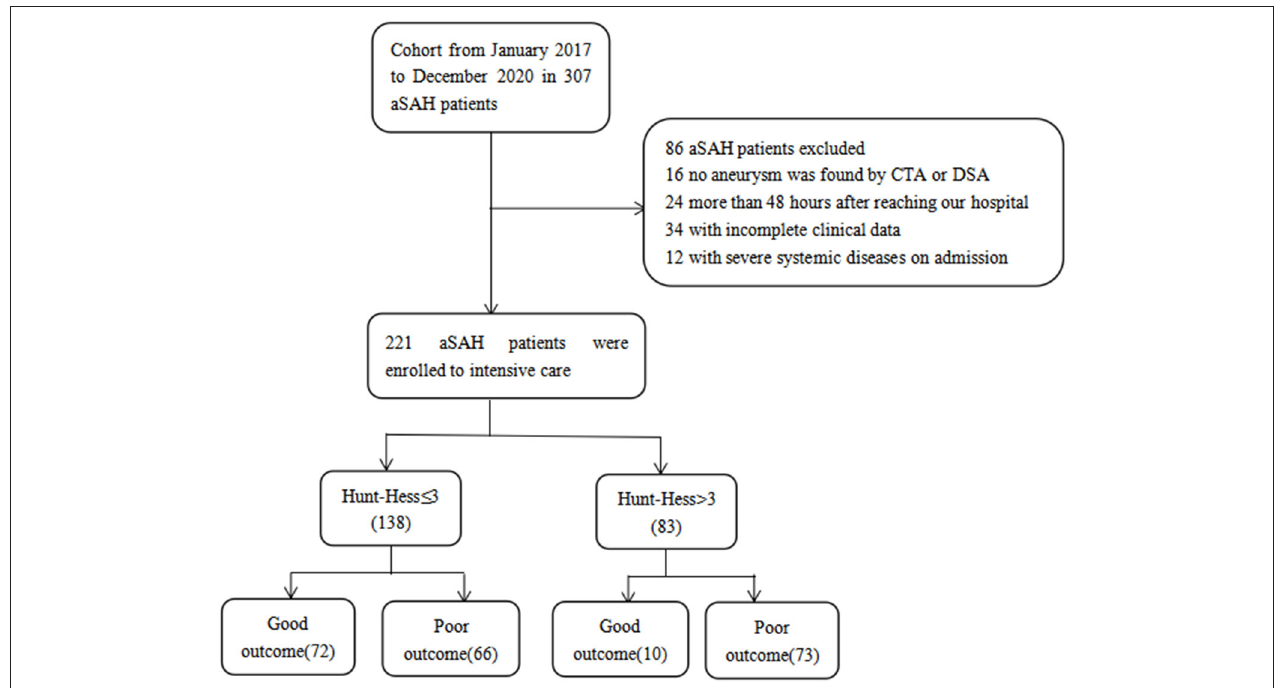
FIGURE 1 | Flowchart illustrating the patient cohort included in this study.